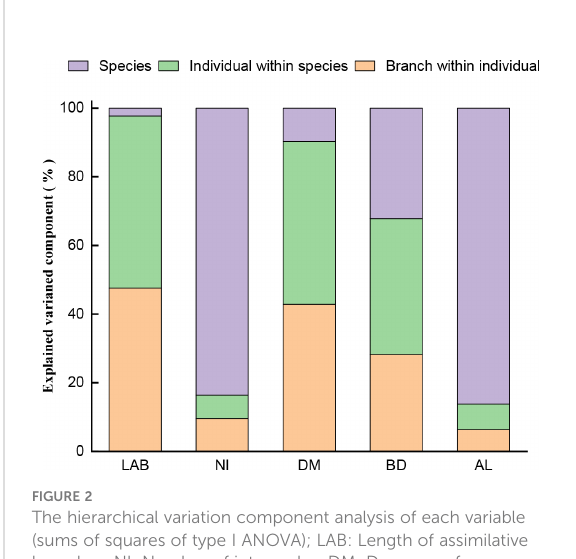
FIGURE 2 The hierarchical variation component analysis of each variable (sums of squares of type I ANOVA); LAB: Length of assimilative branches, NI: Number of internodes, DM: Dry mass of assimilative branches, BD: Average basal diameter of assimilative branches, and AL: Average length of the fi rst three internodes of assimilating